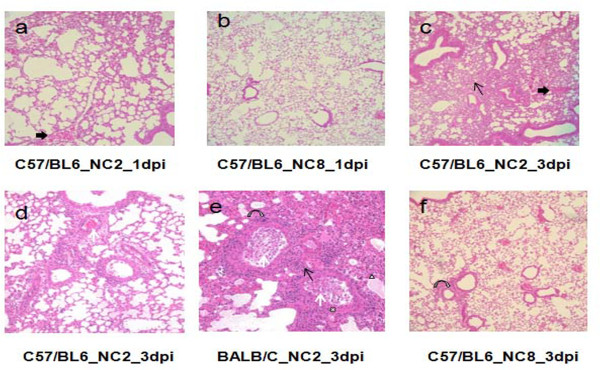
Lung pathology of mice infected with different viral strains. The figure shows lung pathology of C57/BL6 mice at 1 d.p.i. (a) and 3d.p.i. (c and d) and BALB/C at 3 d.p.i. (e) after NC2 infection. In contrast NC8 infected C57/BL6 mice show no (b) and very mild (f) pathological signs at 1 and 3 d.p.i. respectively. Thin arrows – inflammation in interstitial space; thick arrows – hemorrhage in respiratory bronchioles; white arrows – infiltrating cells in lumen of terminal bronchiole; curved arrows – inflammation in peribronchial area; white triangle – pulmonary edema; white cross – damaged epithelium.